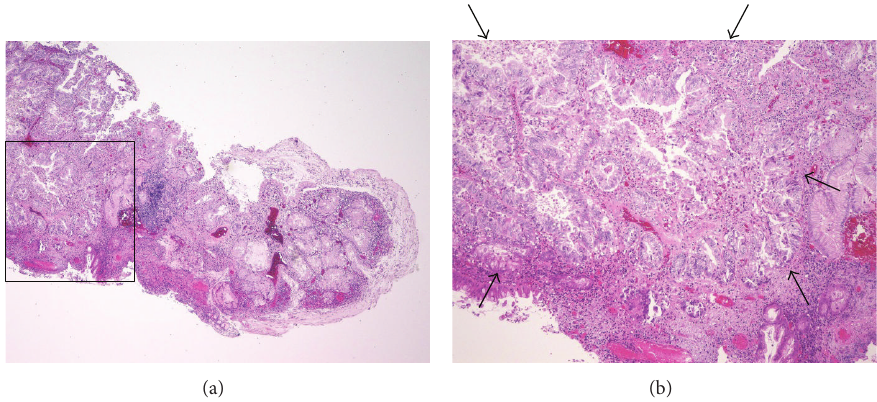
Figure4:Case2,histopathologicalfindings.(a)ResectedspecimenobtainedbyendoscopicEMR(H&E, × 4).(b)Theblackboxin(a)indicates the region shown in the enlarged image. Foci of carcinomatous transformation (between arrows) in the setting of HP are observed (H&E, × 20). EMR: endoscopic mucosal resection; HP: hyperplastic